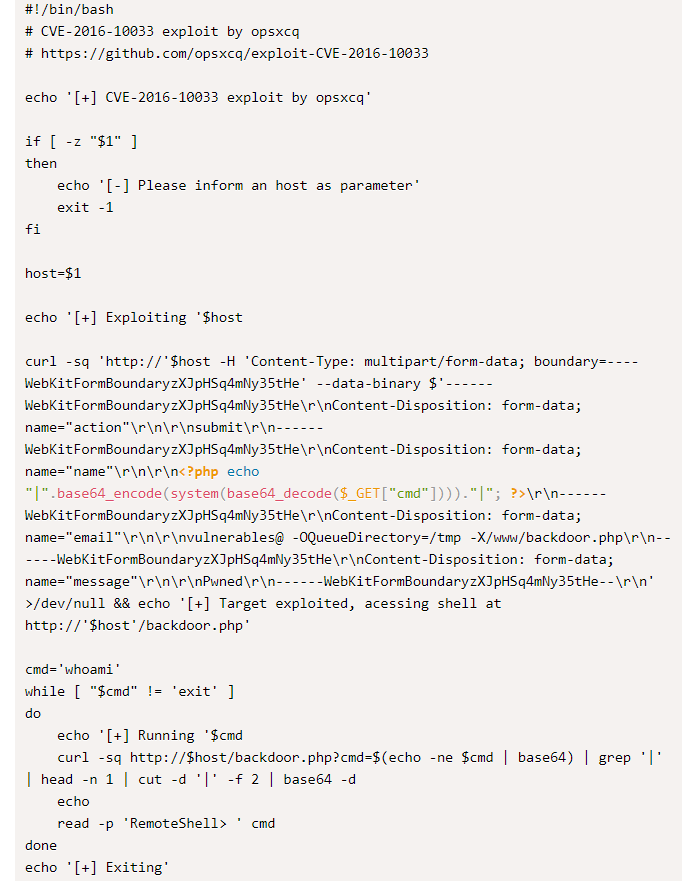
Figure 2. CVE-2016-10033 PoC code in Exploit DB [25].